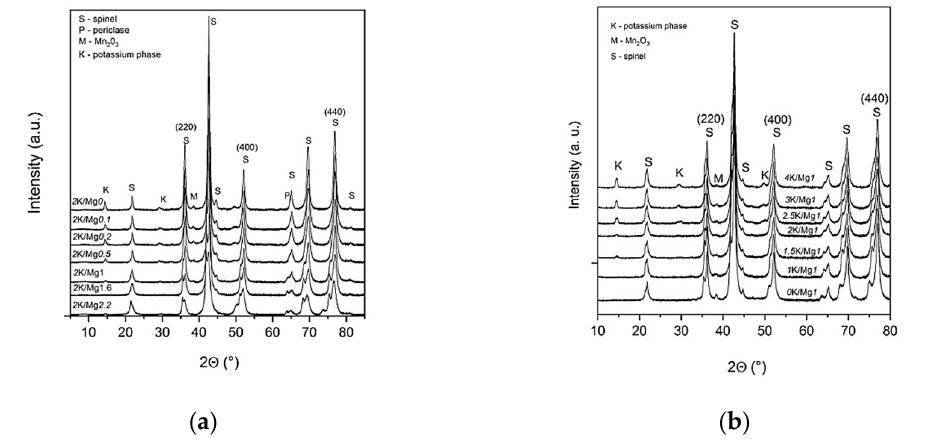
Figure 5. XRD patterns of ( a ) 2K/Mg i catalysts, ( b ) and a K/Mg1 catalysts.